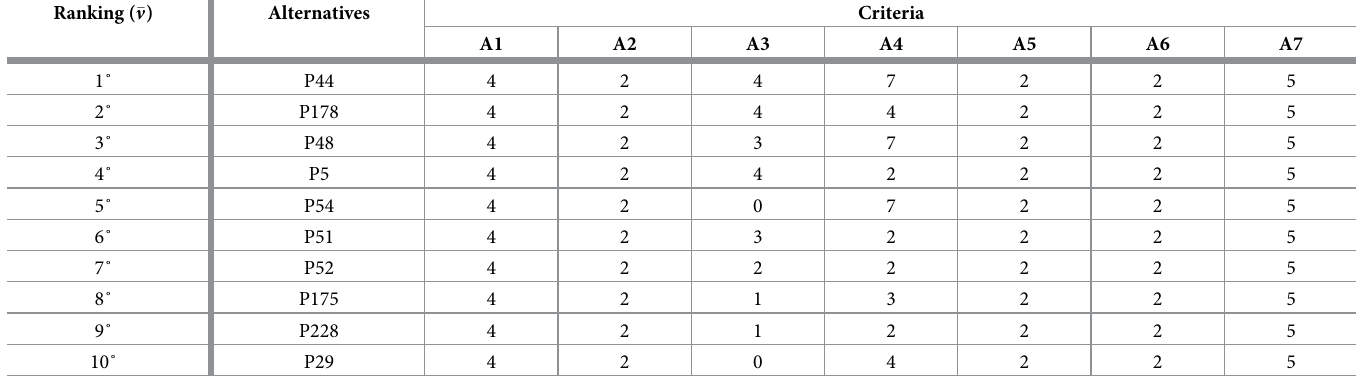
Table 5. Ranking of alternatives obtained with ELECTRE